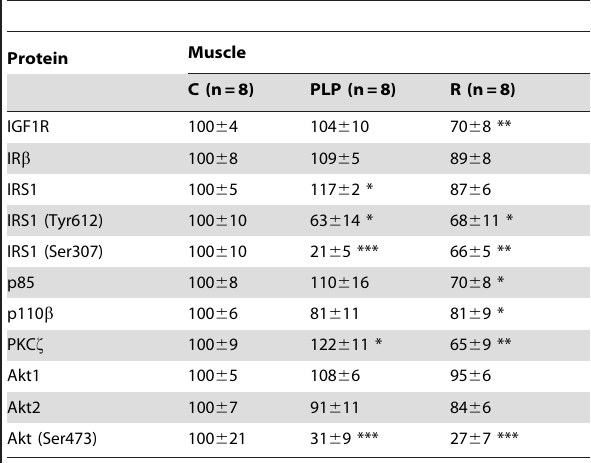
Table 1. Expression levels of insulin signalling proteins in muscle.